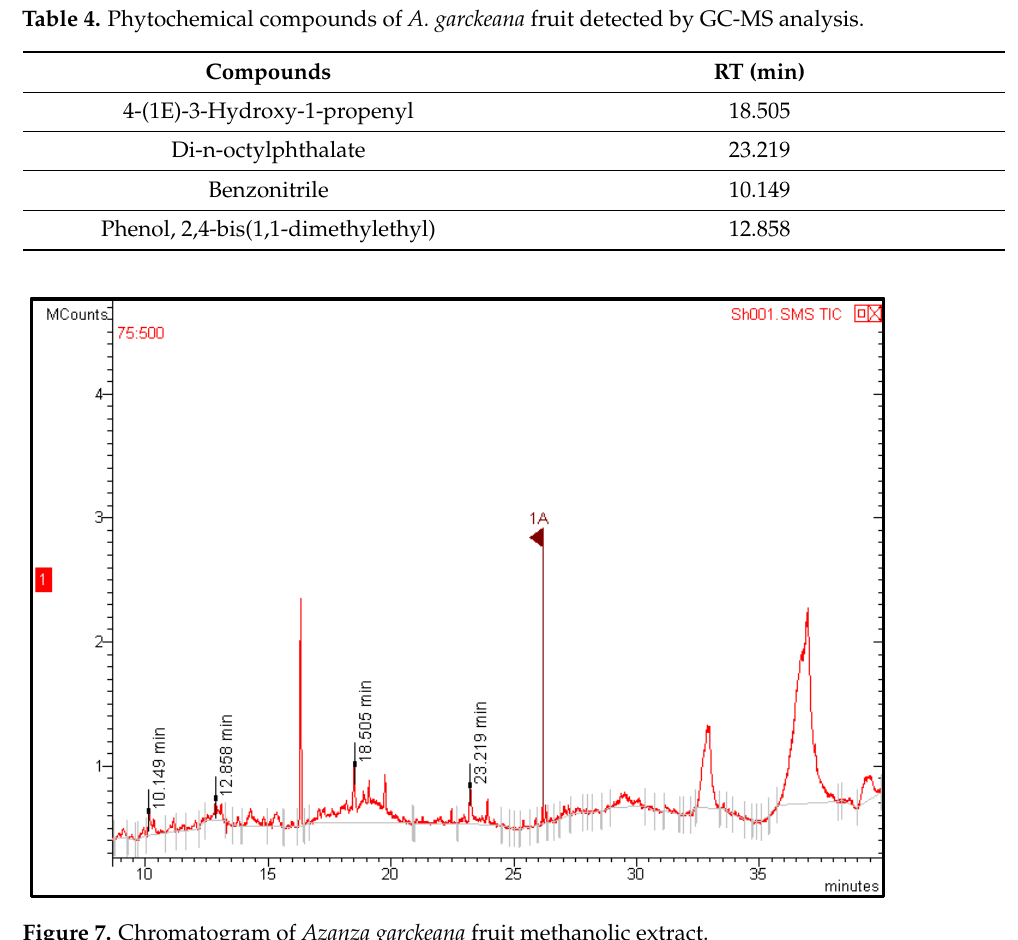
Figure 7. Chromatogram of Azanza garckeana fruit methanolic extract.